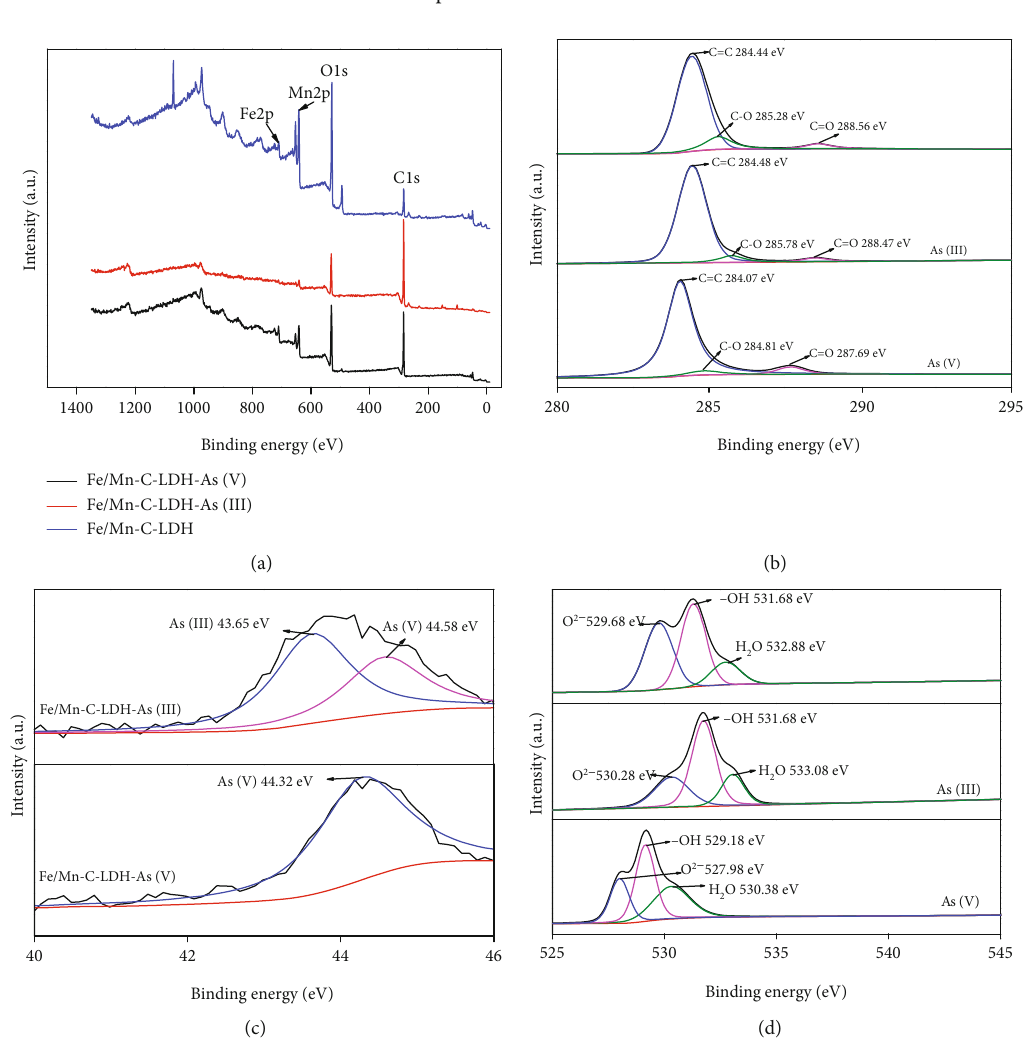
Figure 3: XPS spectra of survey (a), C 1s (b), As 3d (c), and O 1s (d) of